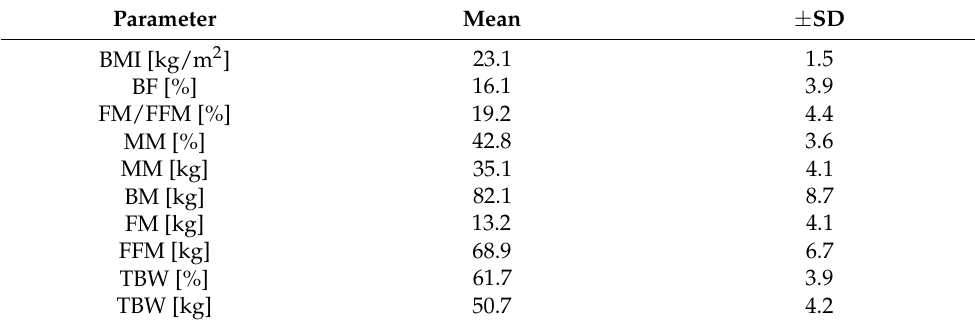
Table 2. Characteristics of the study group at baseline: body composition analysis.